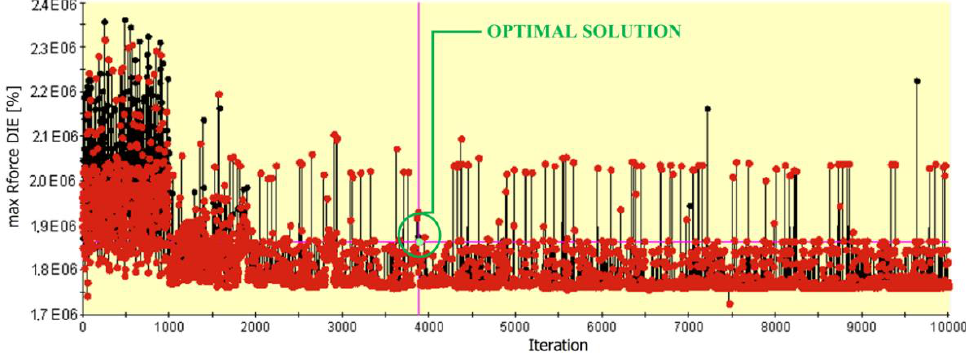
Figure 26. Linear correlation matrix, blank 0.